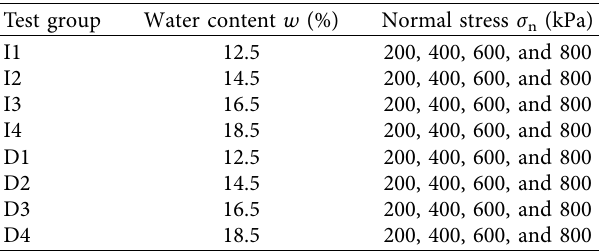
Table 2: Test schemes of this